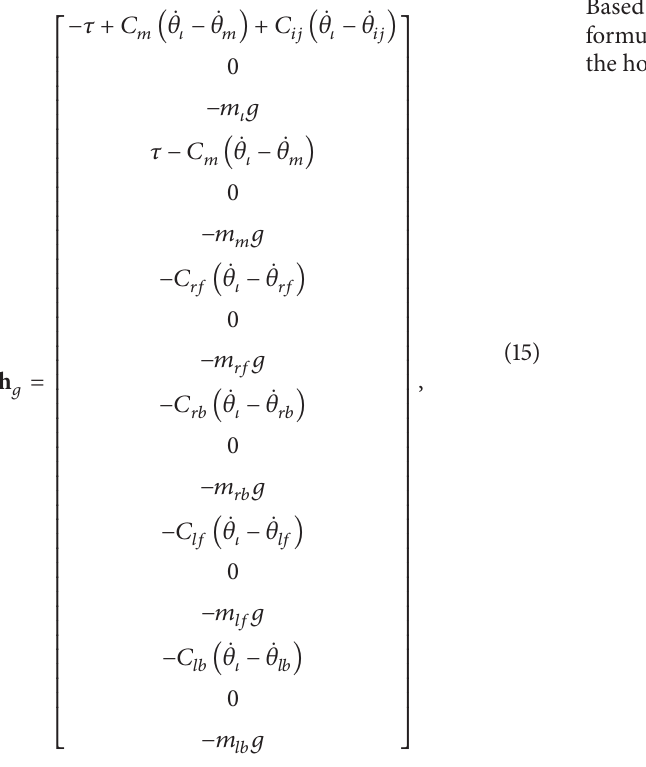
with 𝜏 representing the input